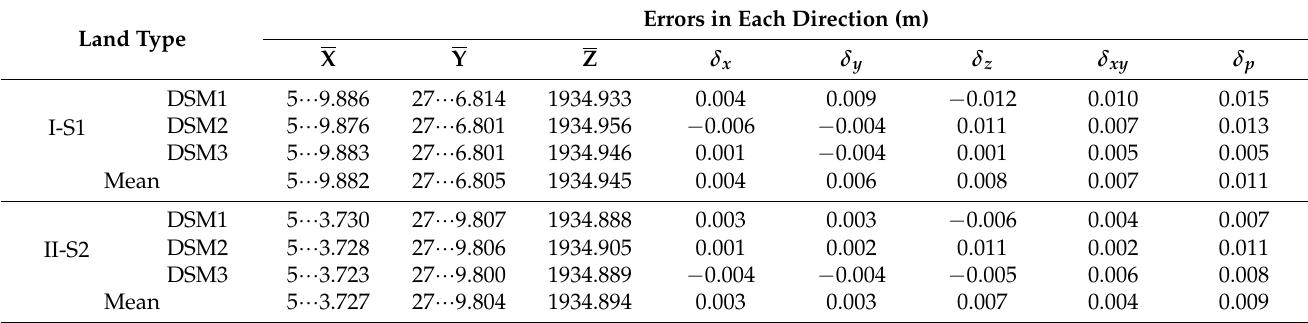
Table 2. 1 * 1 m window sampling 3D point set accuracy analysis